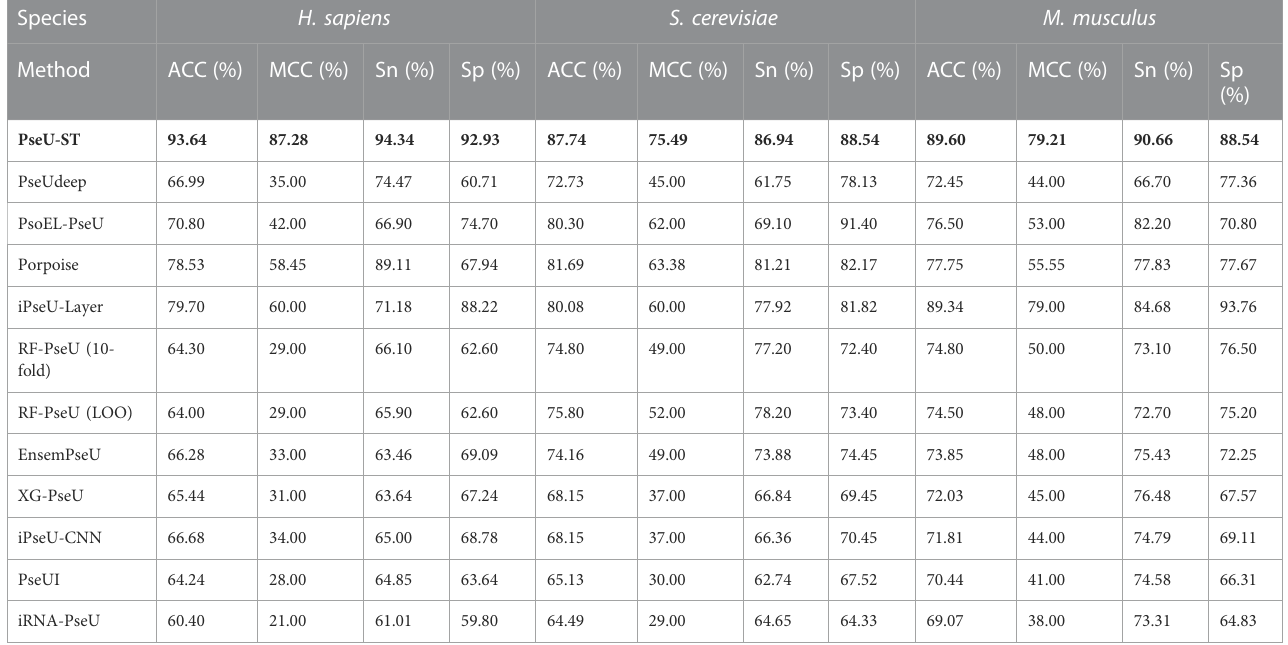
TABLE 4 Performance comparison of PseU-ST and other existing methods on the same benchmark training datasets. Species H. sapiens Method